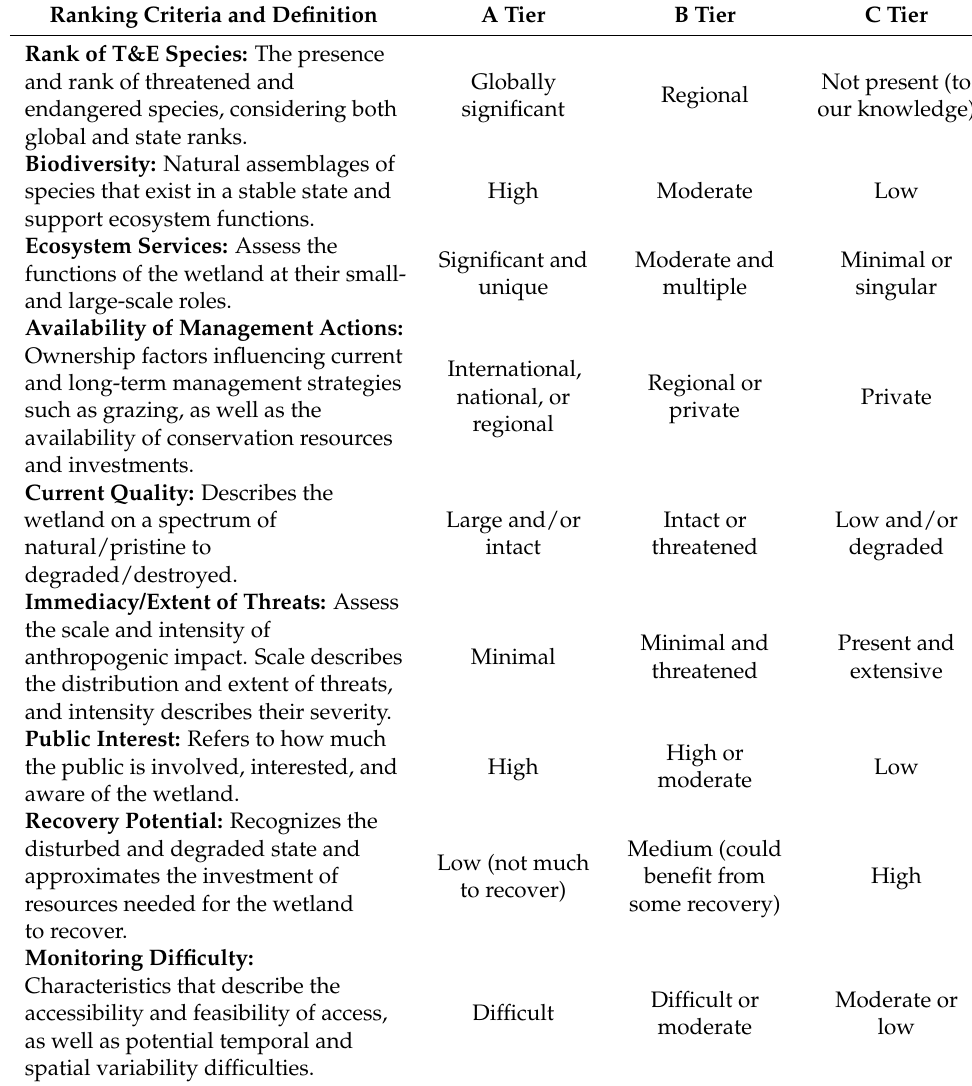
Table 2. Classification criteria and ranking criteria for